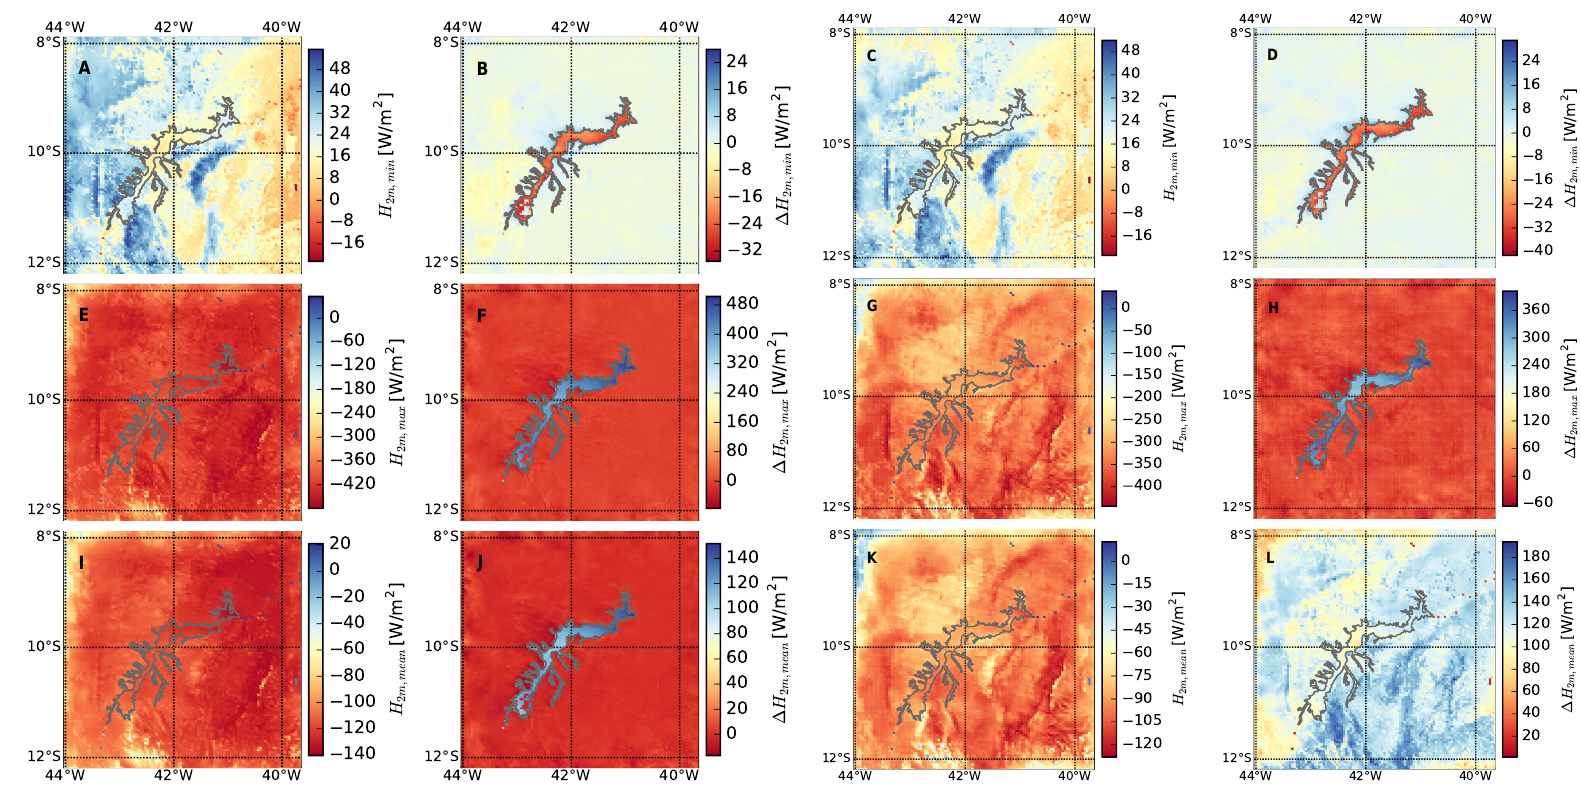
Figure 7. Same as in Figure 4 for the sensible heat